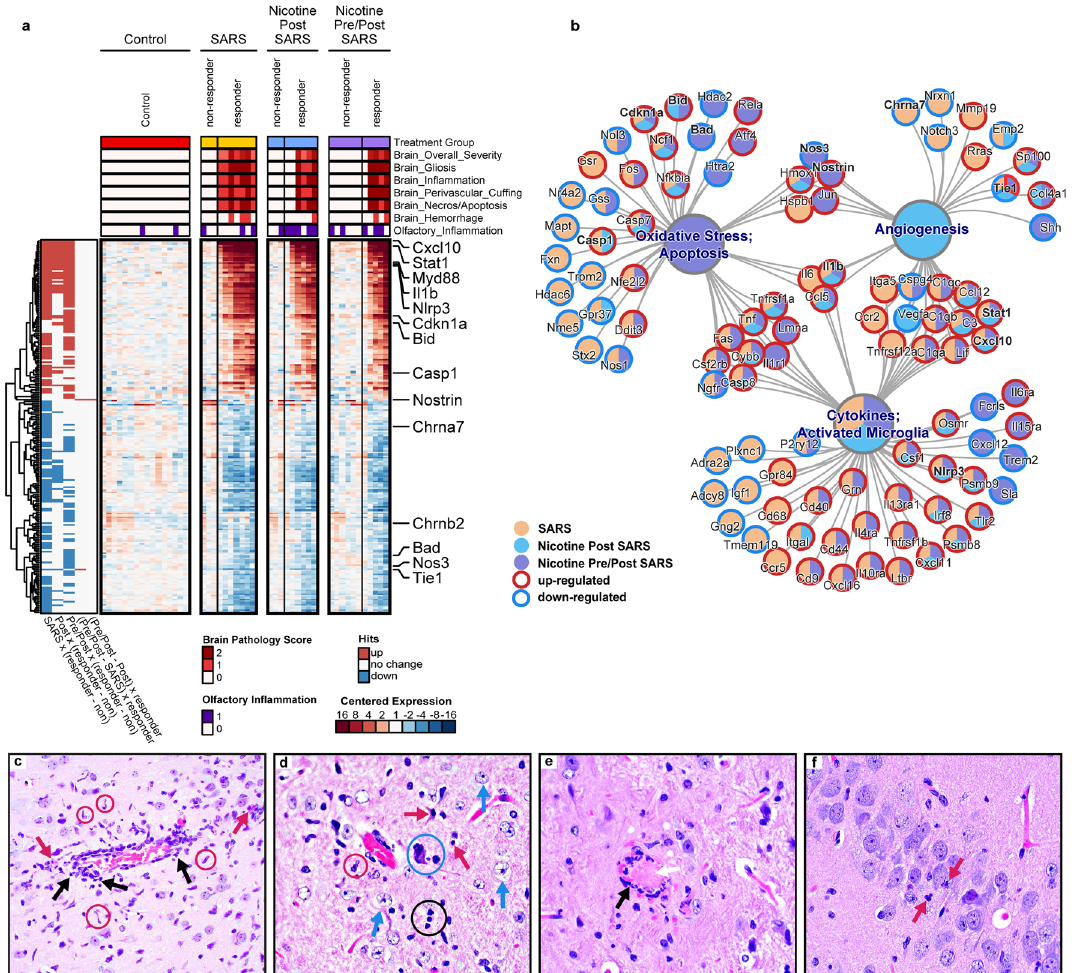
Figure 7. Neuropathology is dependent on expression of SARS-CoV-2 RNA in the brain. ( a ) Heatmap of neurology-related transcripts in rows, and individual mice in columns, shown as log 2 difference from Control mean. Transcript abundance changes that met statistical thresholds are indicated on the left bar for each comparison. The presence of histopathology is represented by a bar in the 2nd–7th rows where darker rows indicate more severe scores. ( b ) Pathway concept network of significantly enriched pathways as large nodes, connected to gene transcripts with significant expression changes as small nodes. Transcript are outlined red for up-regulation, blue for down-regulation, in responders versus non-responders. Nodes are shaded by the treatment group or groups that met the relevant statistical thresholds. ( c ) Perivascular cuffing of a mid-sized vessel surrounded by reactive glial cells predominantly composed of microglial cells (red circles). Infiltrates also appear to travel into the neuropil (black arrows). Necrotic neurons are present (red arrows). ( d ) Perivascular glial response that is predominantly astrocytic (blue arrows). Neuronal necrosis (red arrows), satellitosis (blue circle), and neuronophagia (black circle) are present. ( e ) A microvessel with necrosis (black arrow) of the endothelium (vasculitis) and a fibrin thrombus completely occluding the lumen. ( f ) A hippocampal CA3 region showing two profiles of necrotic neurons (red arrows) with shrunken hypereosinophilic cell bodies and karyorrhectic